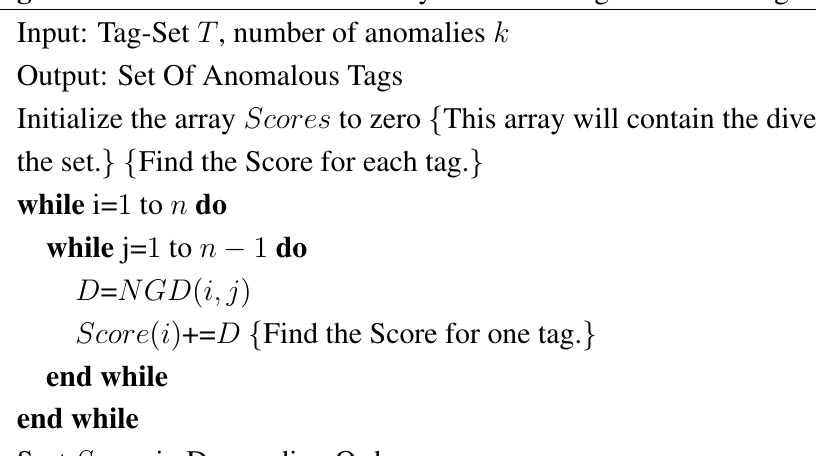
Algorithm 2 The Semantic Anomaly Detection Algorithm For